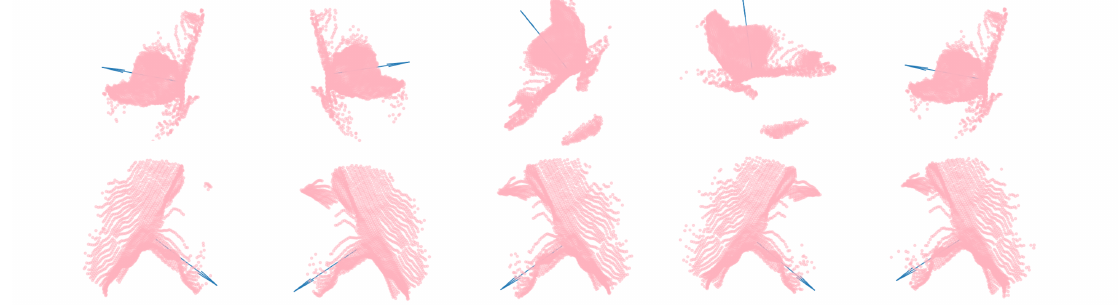
Figure 6. Point cloud crops shown with arrows representing the demonstrated cutting planes.